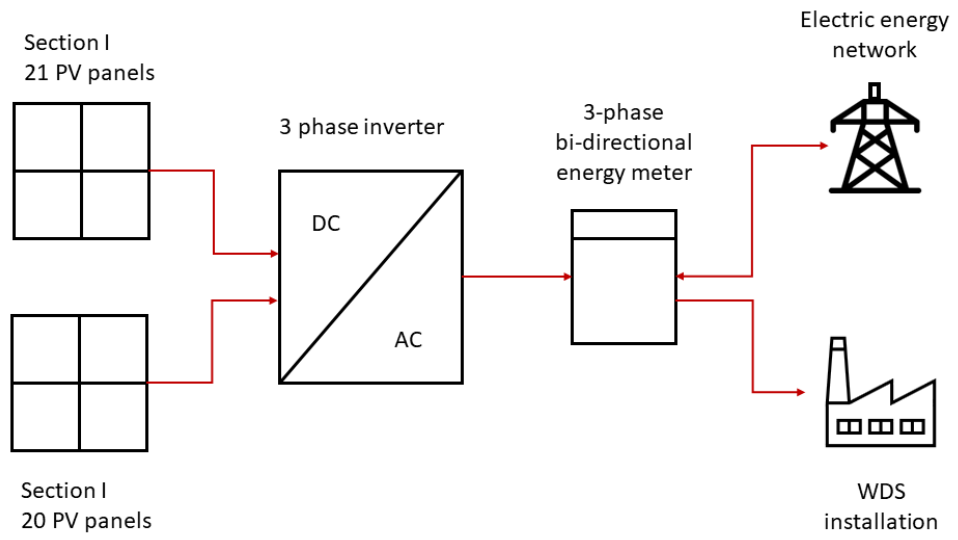
Figure 2. Schematic of PV installation.